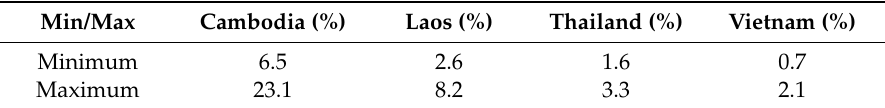
Table 3. Projected loss in fish protein due to hydropower development to 2030 as a proportion (%) of all national protein supply. The range reflects uncertainty as to the portion of the Mekong wild fish harvest caught in each country (after